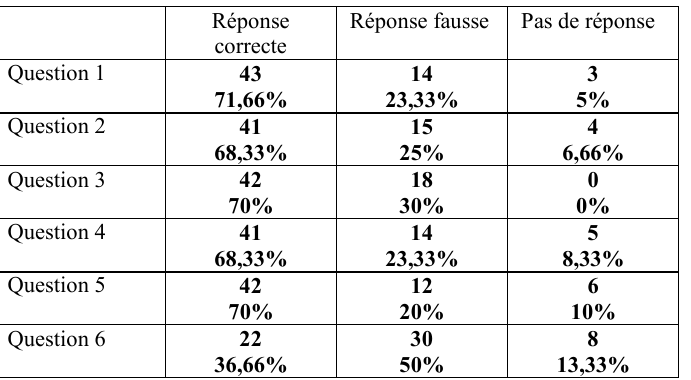
Tableau 4. Résultats de l’analyse des réponses à l’exercice 3 du questionnaire